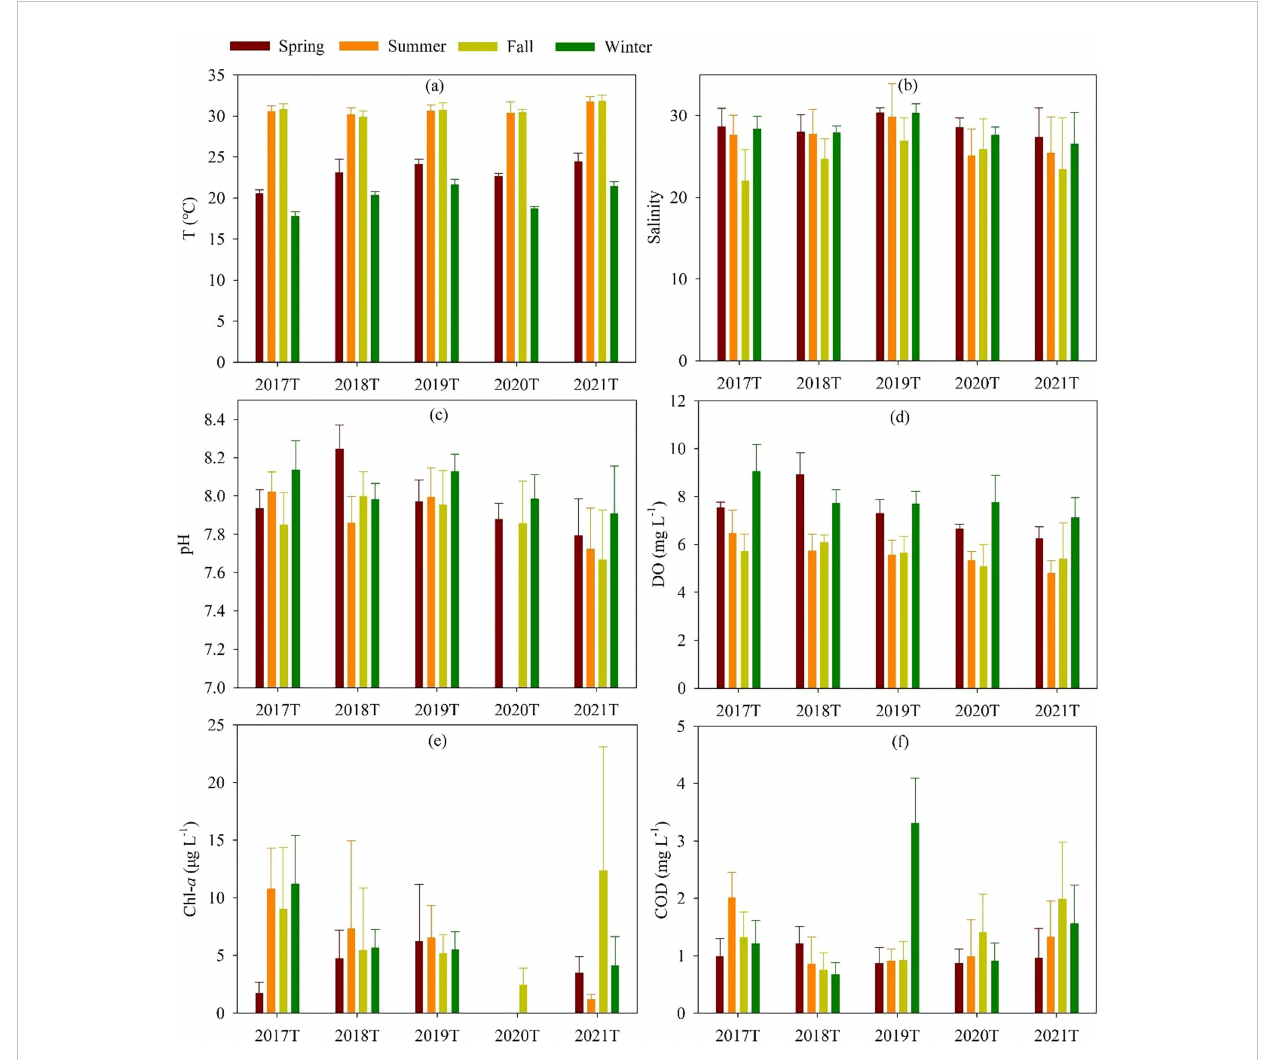
FIGURE 2 Seasonal distributions of temperature, salinity, pH, DO, Chl- a and COD in Zhanjiang Bay from 2017 to